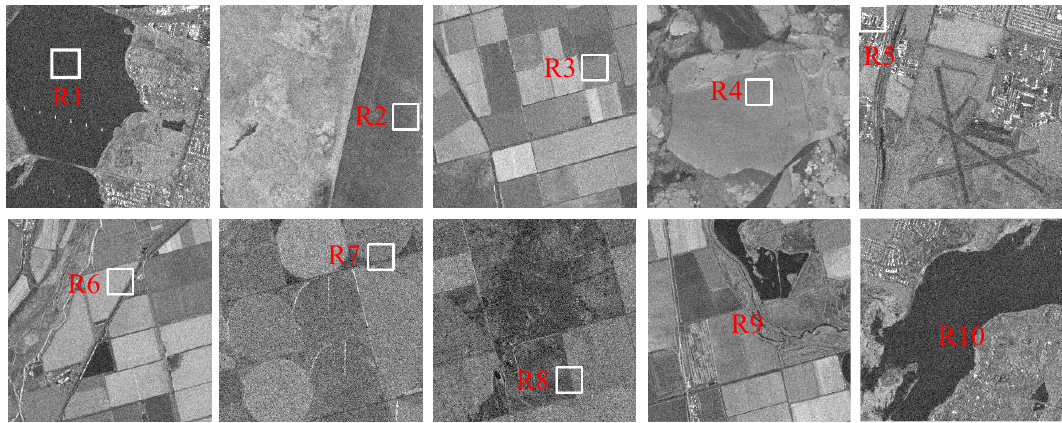
Figure 7. Real-world SAR images for